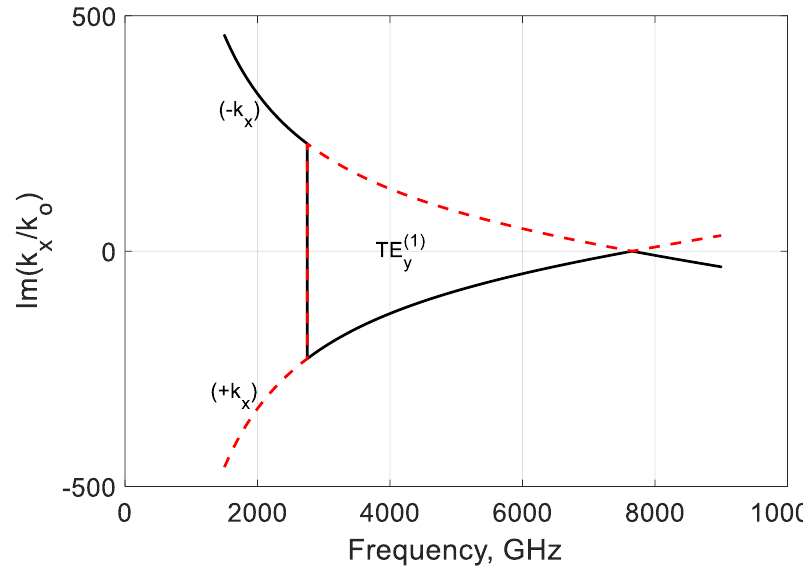
( 1 ) Figure 8. Normalized imaginary part of 0 x k k of the   1 y TE backward mode of a graphene H- Figure 8. Normalized imaginary part of ∓ k x / k 0 of the TE y backward mode of a graphene H-waveguide waveguide of the height 0.01 mm b  and width 2 a  , 3.84 r   , and 1. r   Parameters used of the height b = 0.01 mm and width 2 a = ∞ , ε r = 3.84, and µ r = 1. Parameters used for calculation for calculation of g  are from Ref. [21]: 300 K T  , 40 meV F E  , and 1 ps.  of σ g are from Ref. [21]: T = 300 K, E F = 40 meV, and τ = 1 ps. For comparison, consider the backward   0 y TM mode (Section 2.3) and calculate the propagation k and       20 02 k k k   . It is seen from Figure 9 that this mode is fast and weakly constants   0 z 0 x r r z coupled to graphene at all frequencies. This weak coupling is explained by the shortening of parallel plates by graphene film.